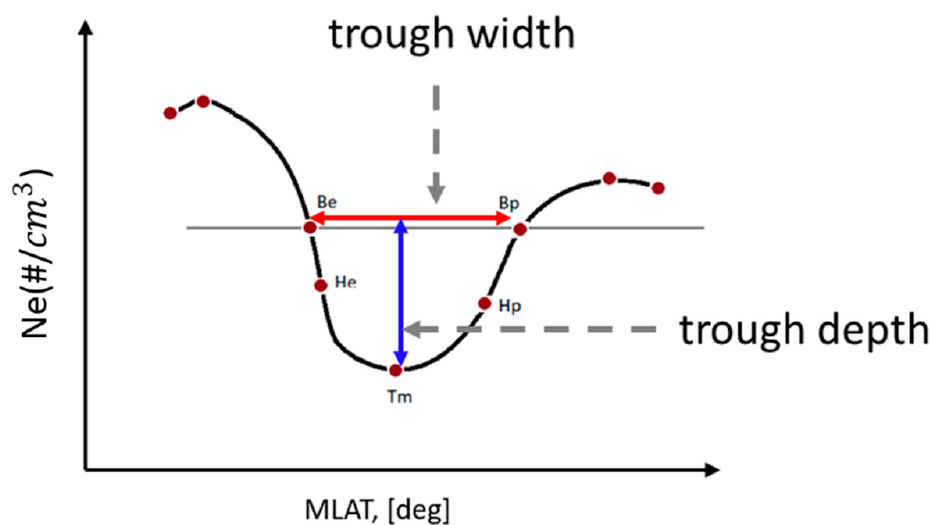
Figure 4. Schematic diagram of the mid-latitude trough characteristic points.